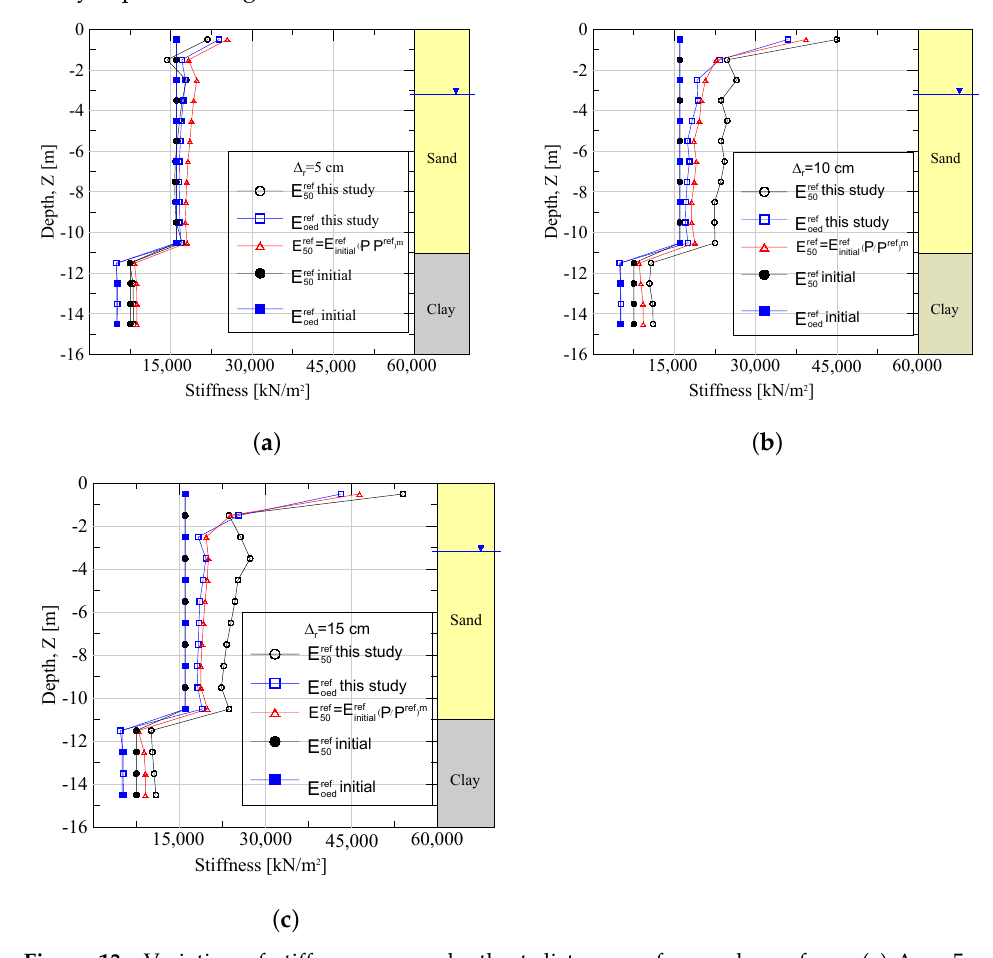
Figure 13. Variation of stiffness versus depth at distance r c from column face. ( a ) ∆ r = 5 cm; ( b ) ∆ r = 10 cm; ( c ) ∆ r = 15